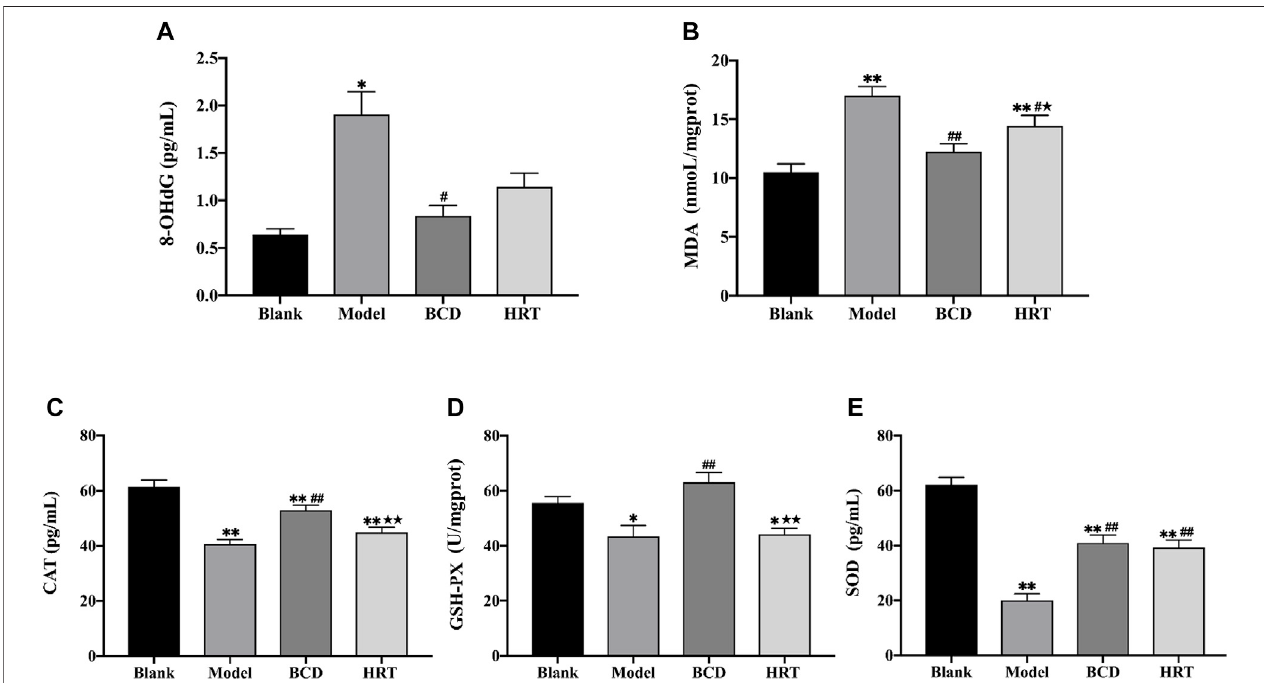
FIGURE5| BCDalleviatesoxidativestressinovariesofPOImice.Therelativecontentsoractivities of (A) 8-OHdG, (B) MDA, (C) CAT, (D) GSH-PXand (E) SODin ovarianhomogenatesupernatantwereanalysed.Thedataisvisualizedintermsofmeans±SEM.(* p < 0.05,** p < 0.01,comparedwiththeBlankgroup; # p < 0.05, ## p < 0.01, compared with the Model group; + p < 0.05, ++ p < 0.01, compared with the BCD